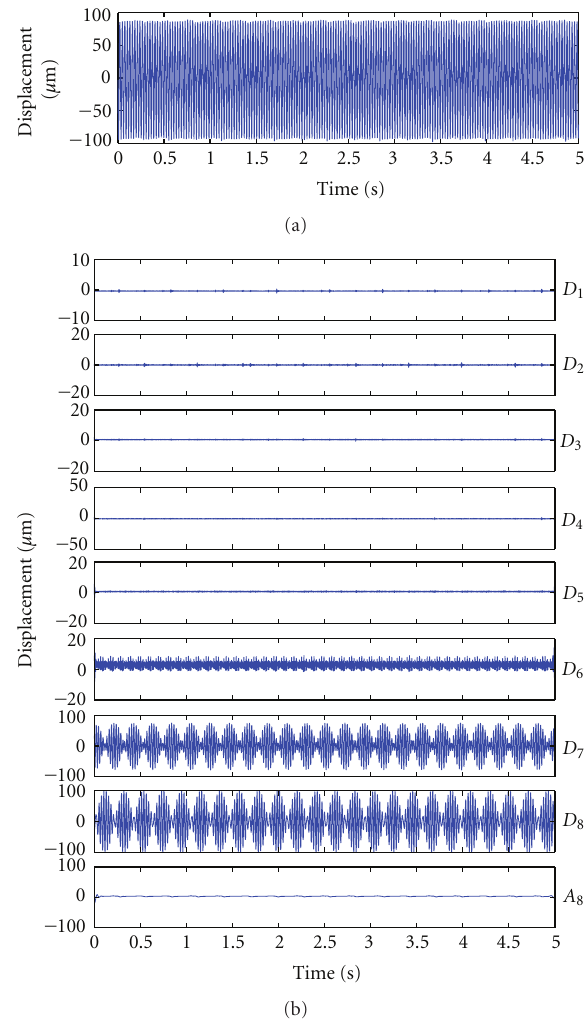
Figure 5: Time series plot (a) and multiresolution decomposition (b) of the vibration signal for cracked rotor with no excitation.